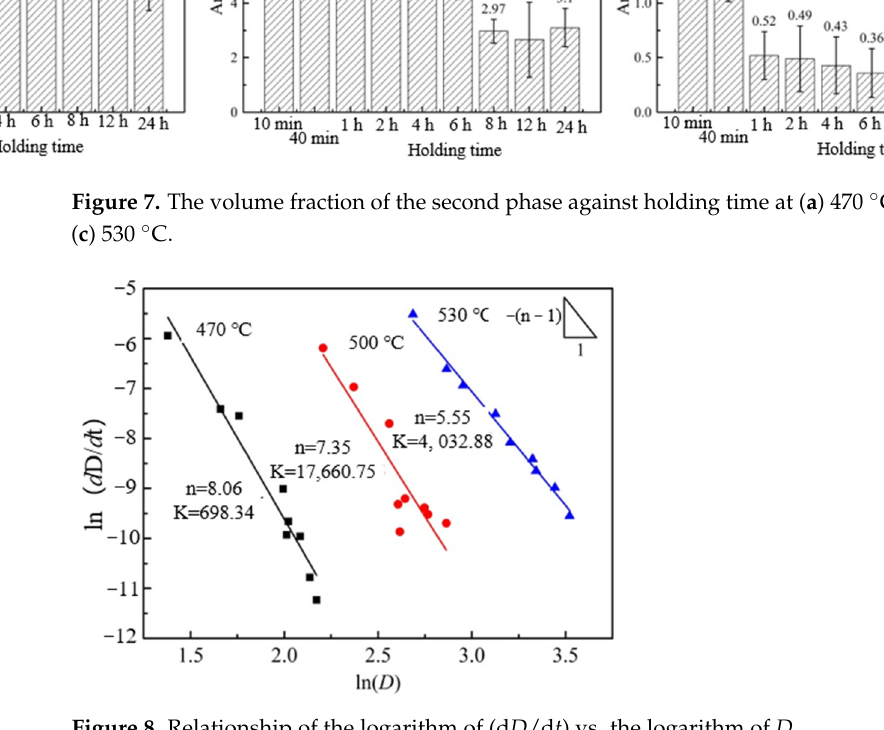
Q R R T + (5) According to Equation (5), the curve of R ln(k) vs. l/ T is then obtained (Figure 9). The value of Q and k 0 can be determined by the slope and intercept in the plot of R lnk vs. 1/T, as shown in Figure 9. However, since only three experimental temperatures were set in this study, only a rough estimate of Q , Q ≈ 150.00 kJ/mol, could be made. 0 ln k=- ln k